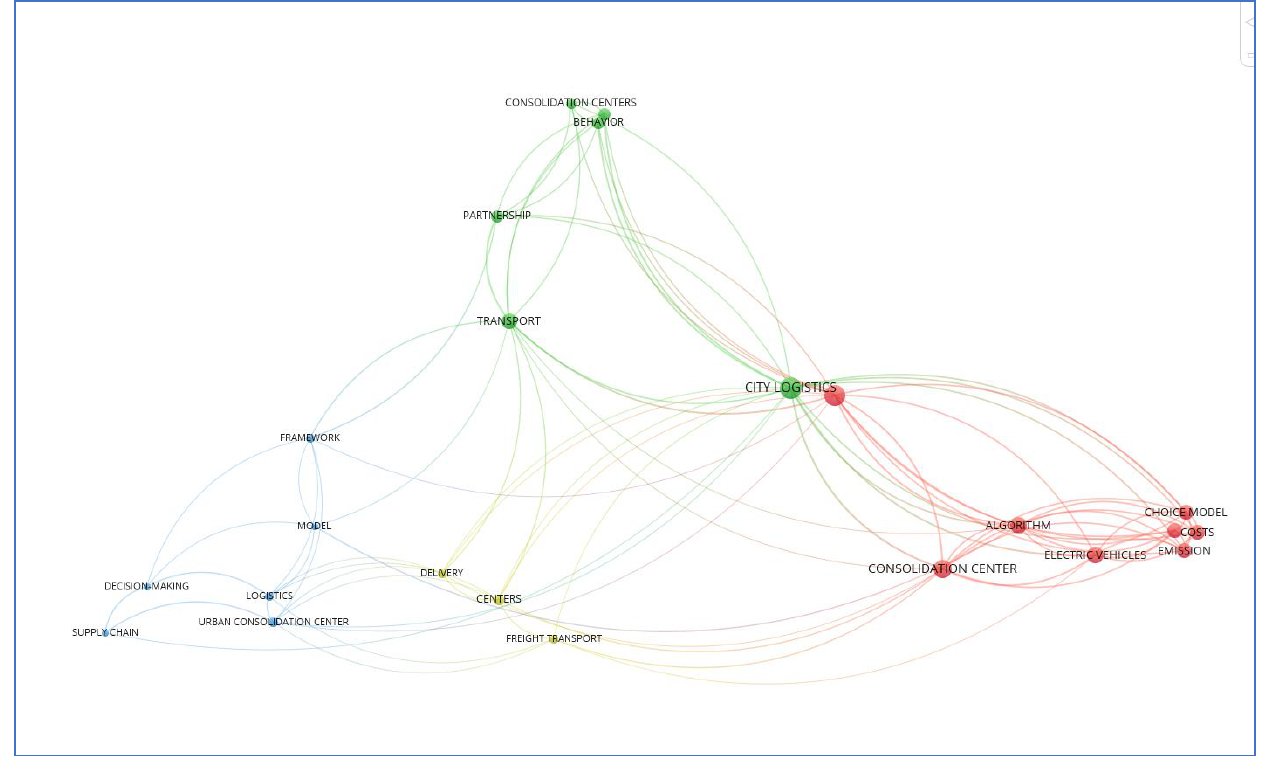
Figure 4. Network analysis of co-occurrence of highly cited keywords. Cluster A (red-colored network) in Figure 4 is the largest cluster with the close